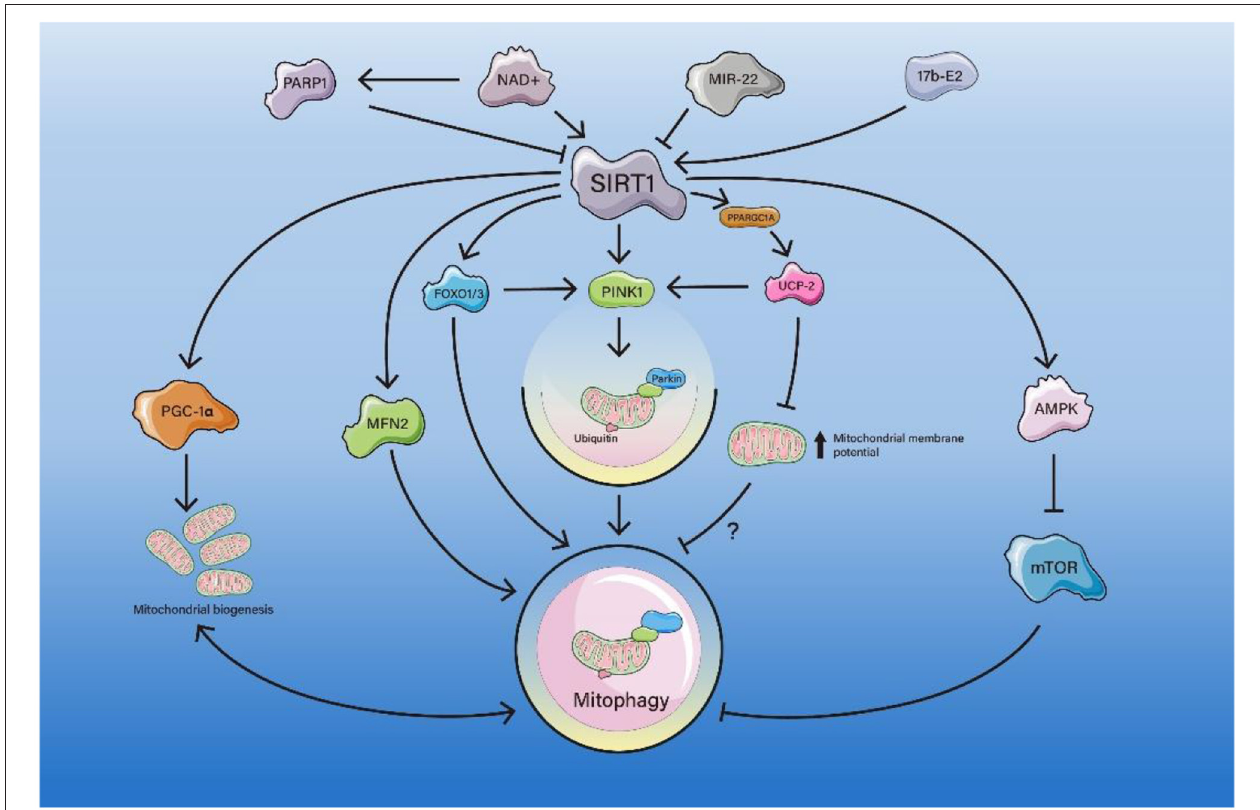
FIGURE 1 | The pathway of SIRT1-mediated mitophagy. PARP1 competes with SIRT1 for NAD + , resulting in inhibition of the SIRT1-PPARGC1A-UCP2 axis, which leads to an increase in mitochondrial membrane potential and inhibition of mitophagy. miR-22 inhibits the SIRT1/PGC-1 α axis and decreases PINK1/Parkin expression, suppressing mitophagy. SIRT1 deacetylates FOXO1/3 and enhances mitophagy directly or by activating the FOXO1/3-PINK1-Parkin axis. SIRT1 deacetylates the K655 and K662 sites of MFN2 and enhances mitophagy. 17b-E2 increases SIRT1 and AMPK expression and decrease the expression of mTOR, thus enhancing